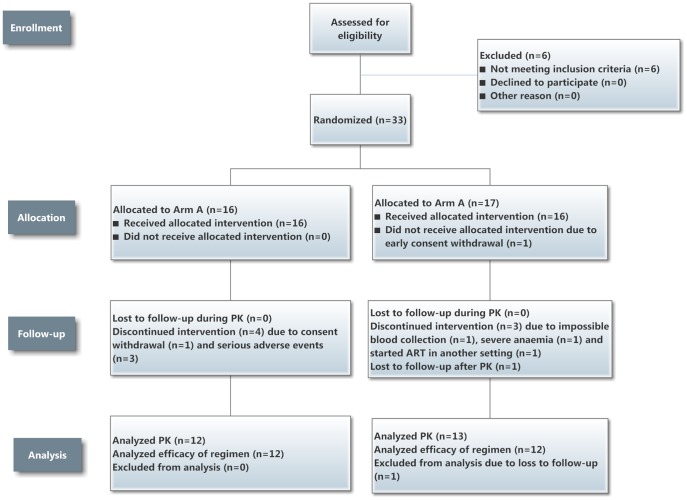
Patient Flow Chart for the trial.PK =  pharmacokinetic analyses